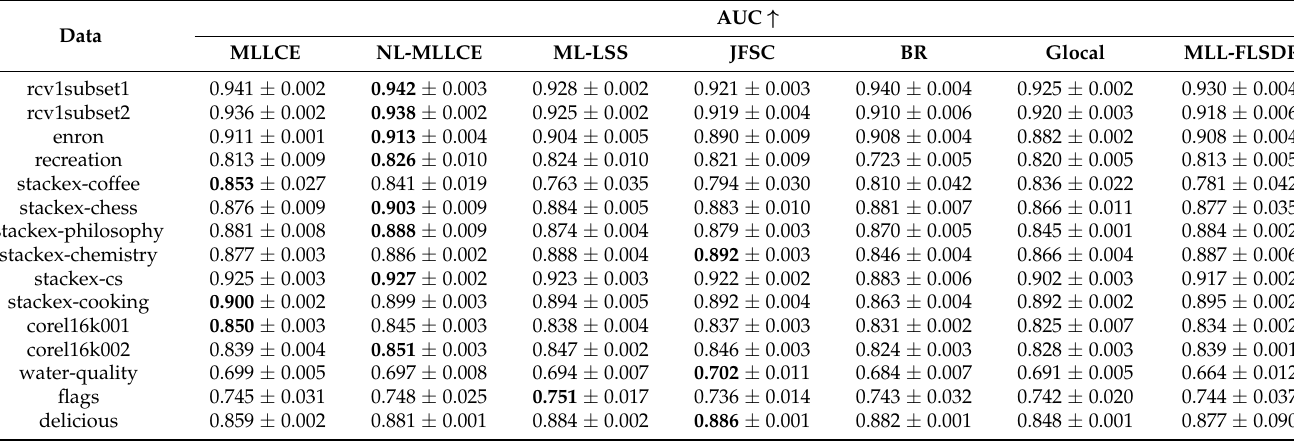
Table 6. The experimental results (mean ± standard) of all comparison methods in this paper in terms of AUC. ↑ means that the larger the value, the better the performance is. The best results in each row are highlighted in bold